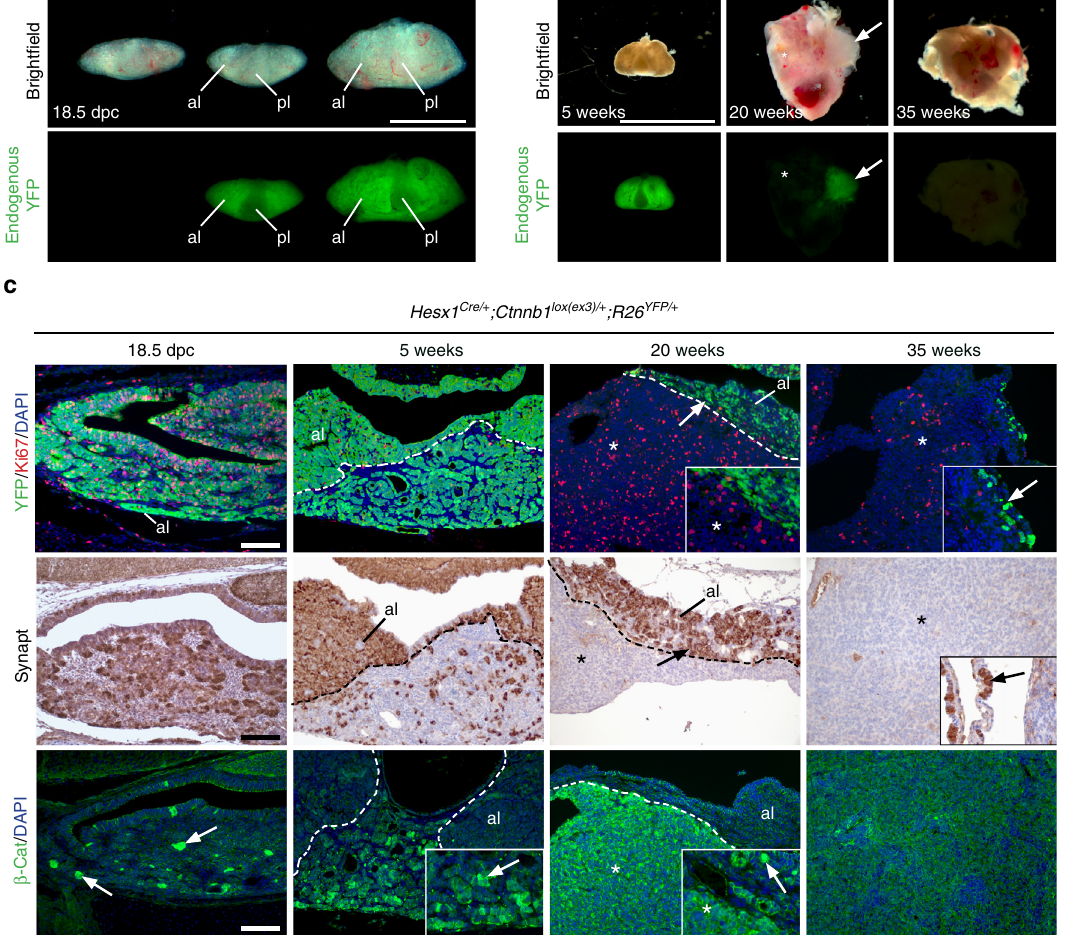
Fig. 1 Tumours in the Hesx1 Cre/ + ;Ctnnb1 lox(ex3)/ + ;R26 YFP/ + mice form non-cell autonomously after a latency period. a Bright fi eld and epi fl uorescence images of 18.5 dpc pituitaries. Note that most of the anterior lobe (al), but not the posterior (pl), is fl uorescent in both the Hesx1 Cre/ + ;R26 YFP/ + control and Hesx1 Cre/ + ;Ctnnb1 lox(ex3)/ + ;R26 YFP/ + pituitaries. The mutant pre-tumoural pituitary is enlarged relative to controls. Scale bar: 1 mm. b Bright fi eld and epi fl uorescence pictures of a pre-tumoural pituitary and tumours in Hesx1 Cre/ + ;Ctnnb1 lox(ex3)/ + ;R26 YFP/ + mutant mice at 5, 20 and 35 weeks of age. Most of the tumour cells are not fl uorescent and the YFP+ population (white arrow) is displaced to the periphery of the growing tumour mass (white asterisks). Scale bar: 5 mm. c Histological characterisation of pre-tumoural pituitaries and developing tumours from 18.5 dpc to 35 weeks postnatally. At 18.5 dpc, most of the embryonic pituitary is comprised of YFP+ cells (revealed with anti-GFP immunostaining), but there are islands of YFP − cells (DAPI+ areas). Abundant Ki67+ cells are distributed throughout the pituitary at this stage. At 5 weeks of age, the pre-tumoural pituitary remains mostly quiescent with very few Ki67+ cells. Note the presence of a dorsal region resembling the normal pituitary tissue of the anterior lobe (al) and a ventral part where YFP − and YFP+ cells are intermingled. The boundary between dorsal and ventral regions is indicated with a dashed line. At 20 weeks, the YFP − population contains abundant Ki67+ cells and has expanded dramatically (white asterisks) displacing the mostly quiescent YFP+ cells to the periphery. Around 35 weeks, mutant mice reach a humane end-point and tumours are mostly YFP − (asterisk). Note that some YFP+ cells are observed in the periphery (white arrow). Immunohistochemistry against synaptophysin shows that whilst the anterior lobe cells (al) are positive, tumours do not express this endocrine marker (black asterisk). Immunostaining against β -catenin showing the presence of cell groups (clusters, white arrows) with nucleo-cytoplasmic accumulation of β -catenin mostly at 18.5 dpc and 5 weeks of age. Subsequently, most of the tumour cells accumulate β -catenin (white asterisk). Results are representative of experiments conducted in at least three different mice for each stage. Scale bars: 100 μ